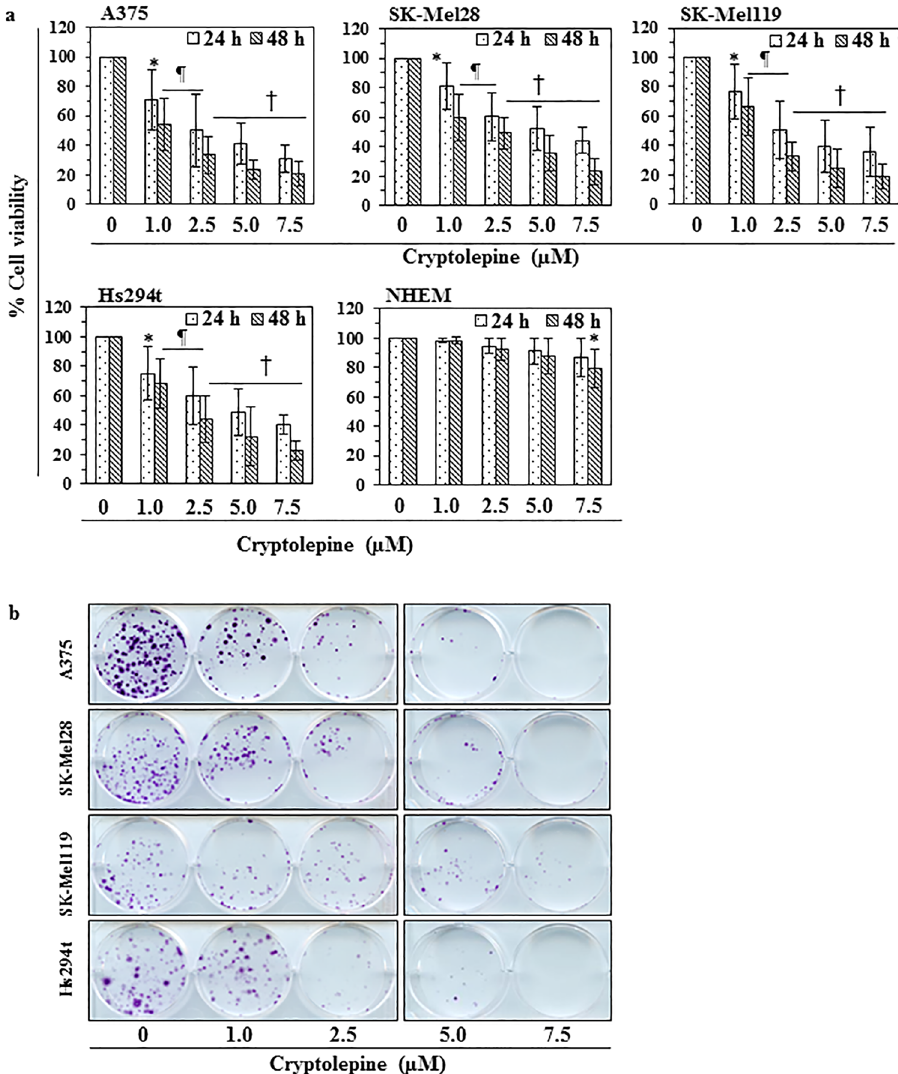
Figure 1. Cryptolepine treatment inhibits the viability and growth of melanoma cells. ( a ) Treatment of melanoma cells (A375, SK-Mel28, SK-Mel119 and Hs294t) and normal human epidermal melanocytes with cryptolepine (0, 1.0, 2.5, 5.0 and 7.5 µ M) for 24 or 48 h inhibits cell viability in a dose- and time-dependent manner. Cell viability was determined using an MTT assay as described in the Materials and Methods. Cells were seeded in 96-well plates in 6 replicates/sample and per treatment group. Cells treated with DMSO alone served as a vehicle control. Statistical significance versus control group, * P < 0.05, ¶ P < 0.01, † P < 0.001. (b) Effect of cryptolepine on the colony forming capacity of melanoma cells. Colonies were detected by staining with crystal violet and plates were scanned for photographs. Colonies appear